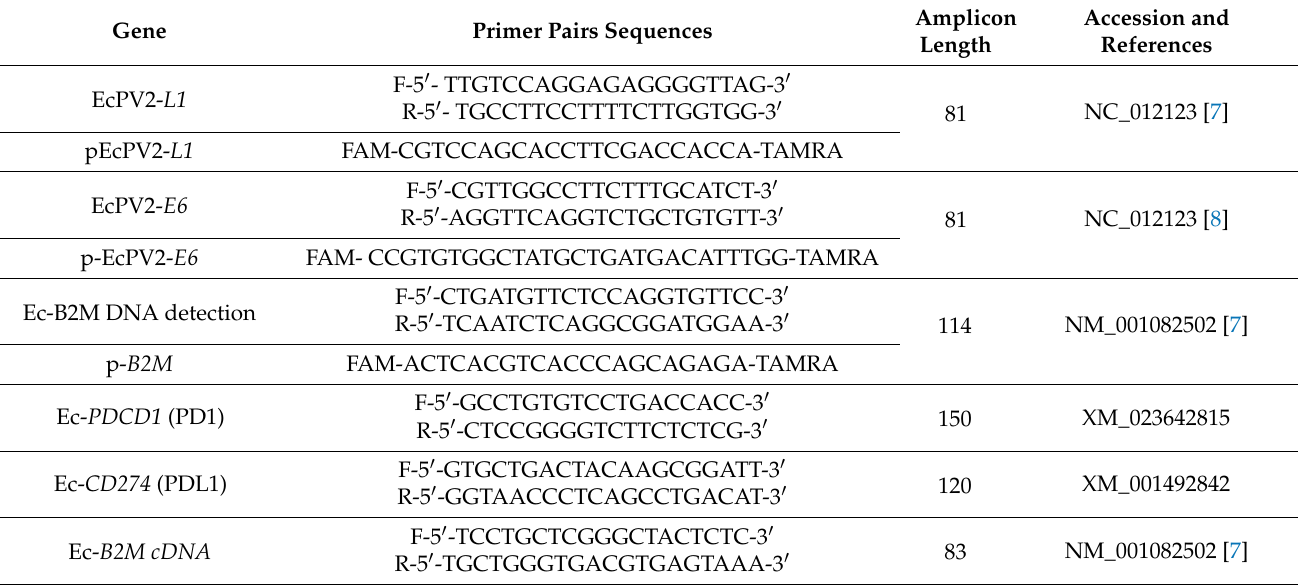
Table 1. Primer pairs and probe